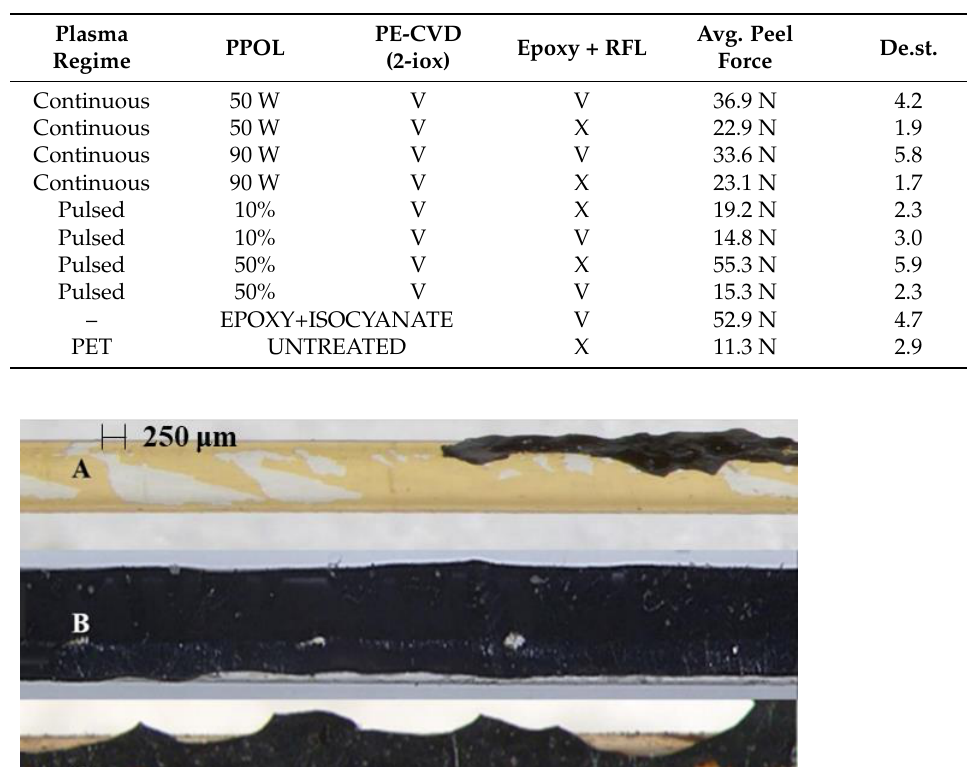
Table 5. Peel test results for the PPOLs obtained at 50, 90 W and at 10% and 50% d.c. In the table, V is used when a treatment is performed, and X is used when no treatment is performed.